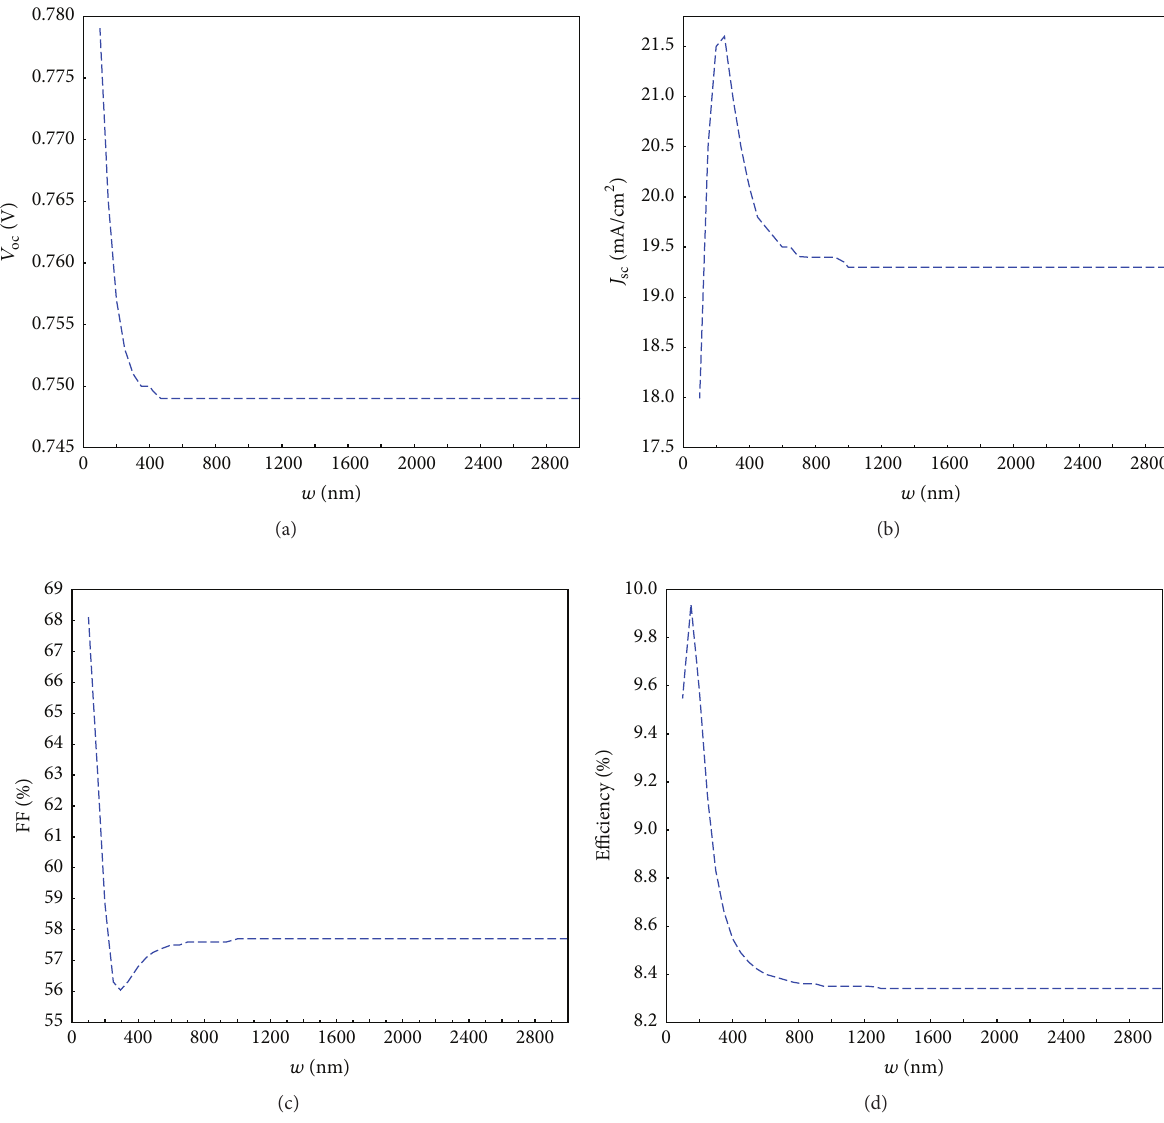
top value for a thickness of 250 nm. This is mainly due to a good collection of carriers across the entire absorber layer thickness. The quantum efficiency curves for different values of absorber thickness are shown in Figure 6. Since the photons of short wavelengths (300 nm < 𝜆 < 450 nm) correspond to the absorption in the window ZnO and buffer CdS layers, we have chosen to focus solely on those which are effectively absorbed in the CZTS absorber layer (450 nm < 𝜆 < 900 nm). The quantum efficiency of cells is higher when the thickness decreases and reaches about 84% for 𝑤 = 250 nm. Therefore, most photons are absorbed for absorber thickness between 250 nm and 600 nm, which increases the solar cell